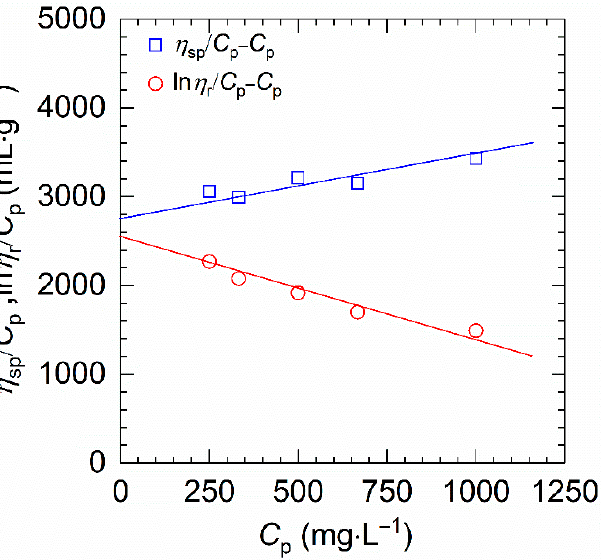
Figure 3. η sp / C p and (ln η r / C p ) plotted against polymer concentration for HVFR in 1 M NaCl solution at 30 °C.